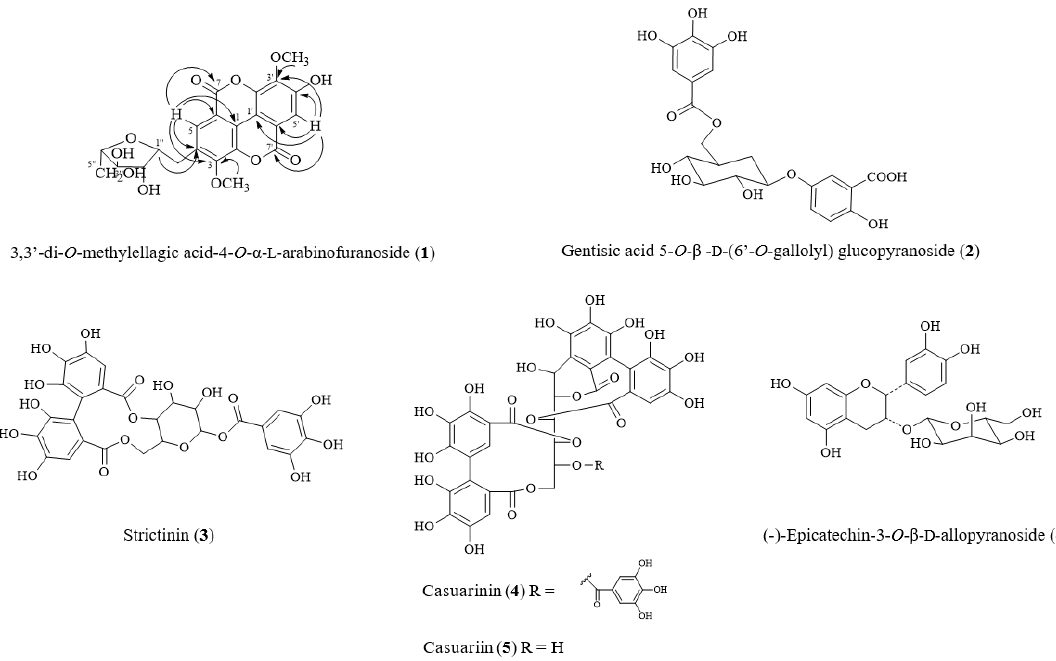
Table 1. 1 H-NMR and 13 C-NMR spectral data of 1 (δ values, in DMSO- d 6 , J in Hz).